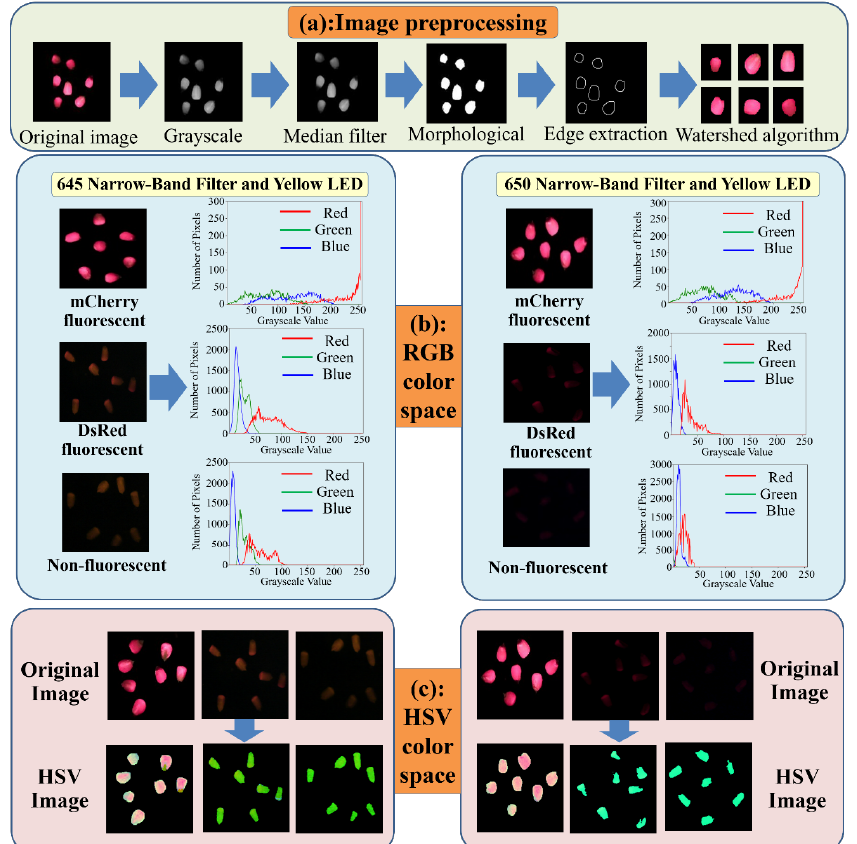
Figure 4. Comparative analysis of excitation light source and filter configurations for fluorescent maize kernels in terms of ( a ) image processing, ( b ) RGB colour space, and ( c ) HSV colour space. Figure 4b,c and Table 3 show the RGB and HSV colour feature parameters of the extracted kernels following the pre-processing and segmentation of the kernel images. As